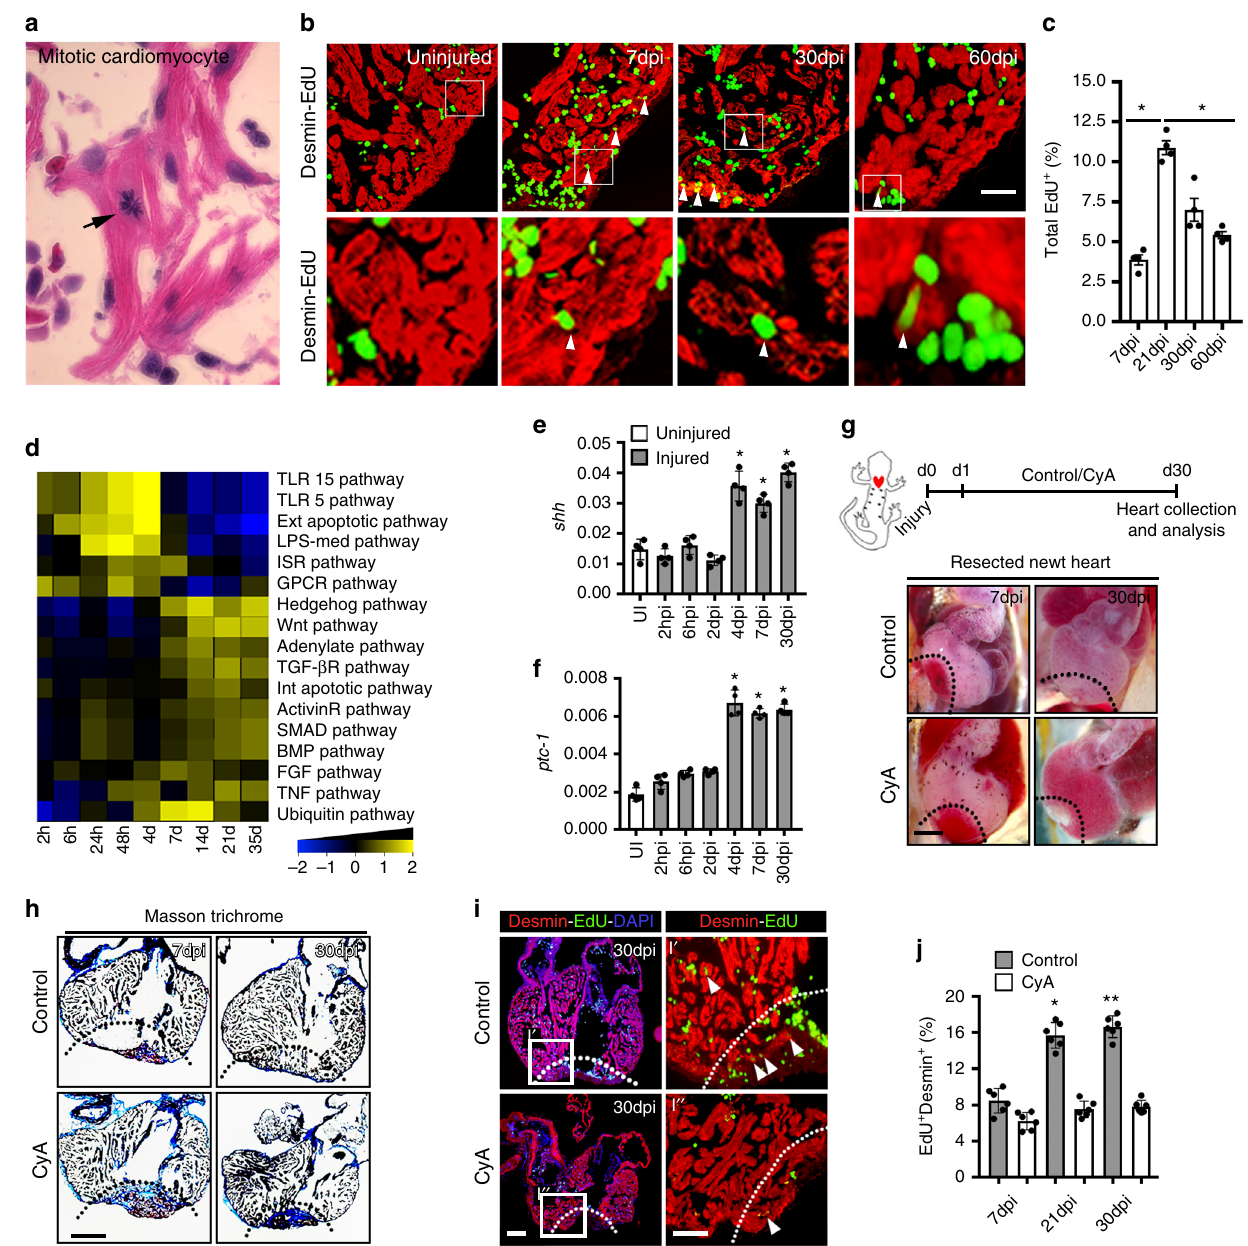
Fig. 1 HH signaling is essential for heart regeneration. a Histological examination of the regenerating newt heart showing a mitotic cardiomyocyte in the injured tissue. b , c Immunohistochemical ( b ) and quantitative analysis of the total EdU + cells ( c ) in the regenerating newt heart. The white arrowheads indicate the proliferating cardiomyocytes within the myocardium at speci fi ed time periods following injury. The boxed regions are magni fi ed in the lower panels. Quantitative analysis represents counts from four randomly selected fi elds at 20× magni fi cation from four replicates at each time period. d Gene set enrichment analysis using Bootstrap tools from regenerating newt heart tissue at the designated time periods postinjury. The color scale indicates the scaled expression levels of signaling pathways following heart injury. e , f qPCR analysis for shh and ptc-1 transcripts during cardiac regeneration in the newt ( n = 4). g Schematic (top) of experimental protocol and whole-mount images of the regenerating heart obtained from control- and CyA-treated newts at 7 dpi and 30 dpi ( n = 8 for each group). The dotted line represents the injured region of the heart. h Masson Trichrome staining of the regenerating hearts from control- and CyA-treated newts at 7 dpi and 30 dpi ( n = 8 for each group). The dotted line represents the injured region of the heart. i , j Immunohistochemical staining ( i ) and quanti fi cation ( j ) of Desmin + -EdU + cardiomyocytes in the regenerating heart from control- and CyA-treated newts at the designated time periods following injury ( n = 6). The dotted line in panel i represents the injured region of the heart and the tissue in the boxed region is magni fi ed in I ′ and I ″ panels. White arrowheads indicate the EdU + -cardiomyocytes. Data are presented as mean ± SEM (* p < 0.05; ** p < 0.01) (see also Supplementary Figs 1 and 2) and scale bars = 200 μ m (panels a , b , h , i ) and 500 μ m (panel g ). Statistical tests were done using